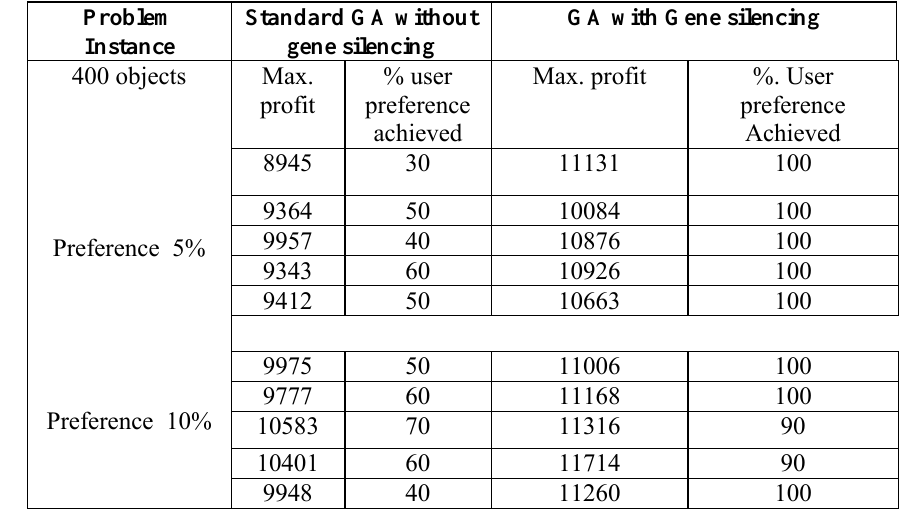
Table 4. Experiment-4 with 400 Objects and Preference of 5 % and